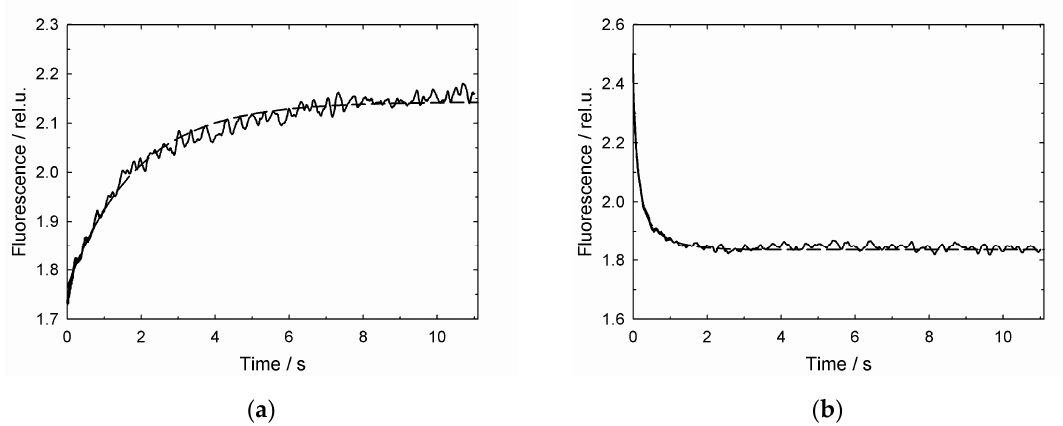
Figure 7. The stopped-flow kinetics of denatured FAM- α -lactalbumin interaction with GroEL ( a ) and GroES, ATP-induced dissociation ( b ). The kinetics was derived from changes in fluorescence intensity of FAM- α -lactalbumin under conditions described in Legend to Figure 3. The dashed line represents an exponential approximation of the kinetics.